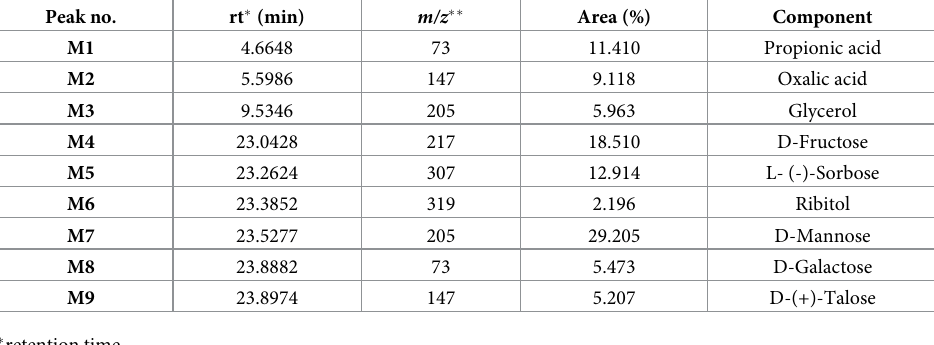
Table 1. Identified contents of the crude extract (CE) as measured using metabolite profiling on GC/MS. Peak